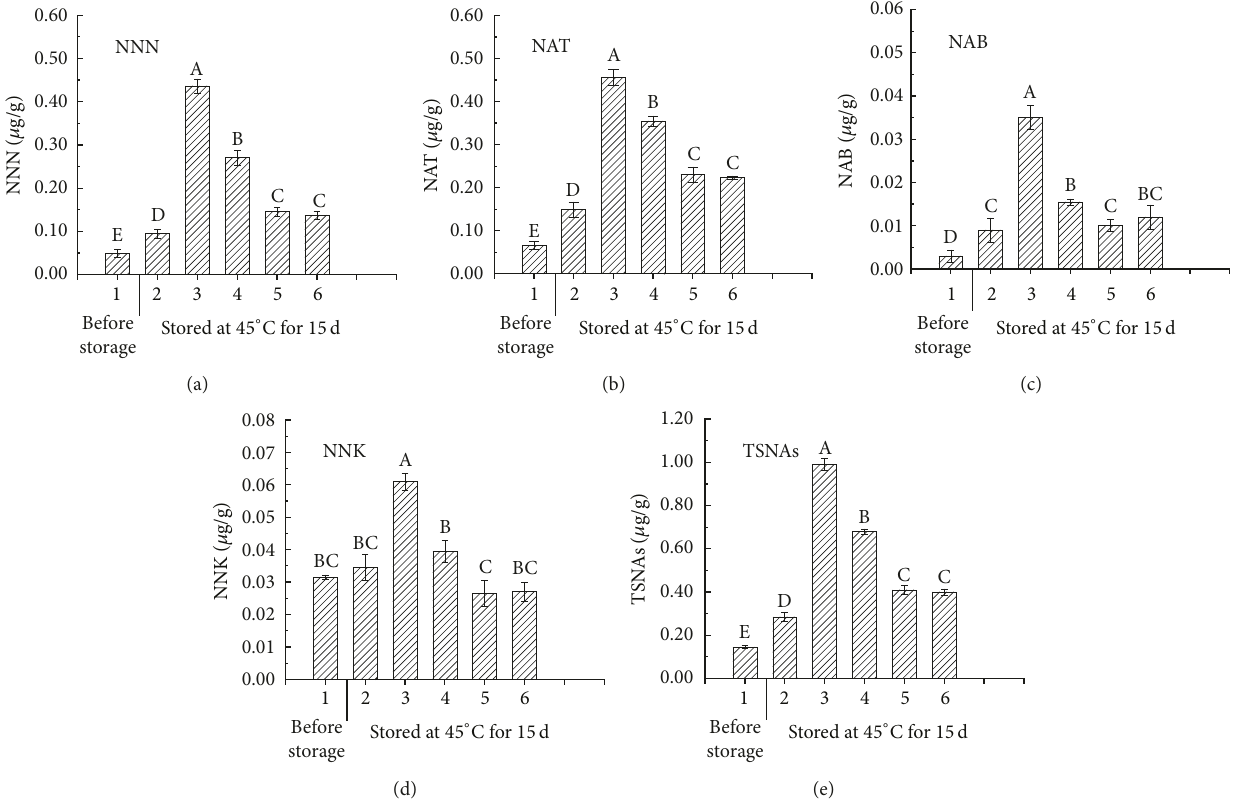
Figure 7: Effect of activated carbon (AC) on TSNAs formation in flue-cured tobacco in response to nitrate addition. Note . (1) tobacco (before storage, 4 ∘ C), (2) tobacco, (3) tobacco + NaNO 3 , (4) tobacco + NaNO 3 + AC 1.0 g, (5) tobacco + NaNO 3 + AC 5.0 g, and (6) tobacco + NaNO 3 + AC 10.0 g, 20 g of flue-cured tobacco, and 0.3 g NaNO 3 (219mg of NO 3− ). The NO 3− , AC, and tobacco were added separately in the vacuum desiccators stored at 45 ∘ C for 15 d. Uppercase letters indicate significant differences between the treatments at 𝑃 < 0.05